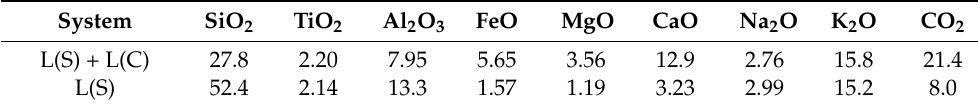
Table 1. Compositions (wt%) of starting mixtures normalized to 100% .